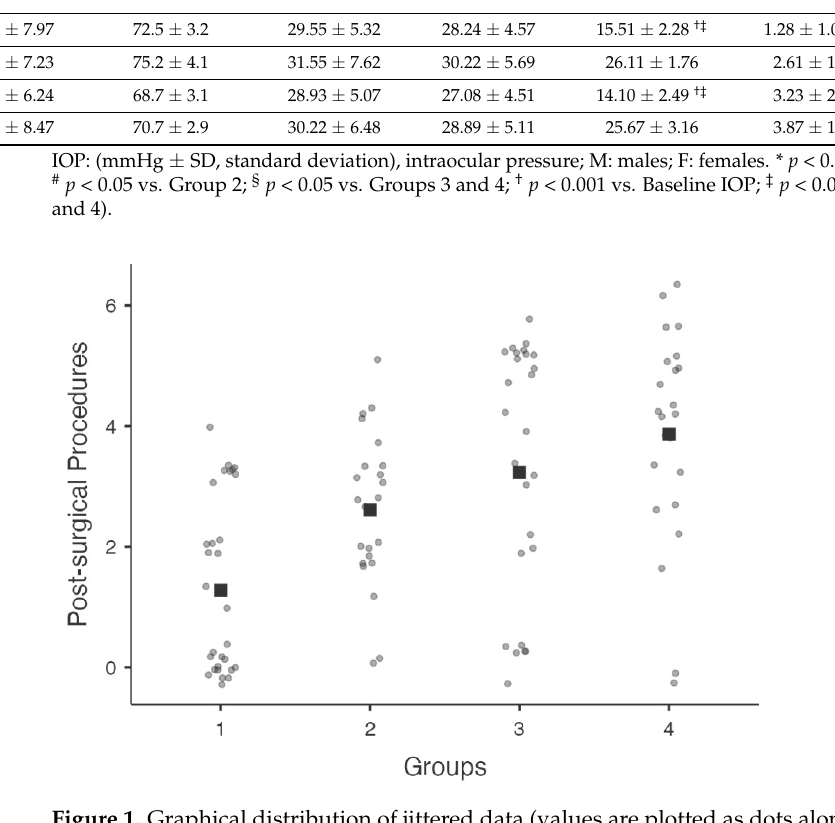
Figure 1. Graphical distribution of jittered data (values are plotted as dots along each axis) among groups representing post-surgical bleb management procedures. Median value is representing by squares along axes.